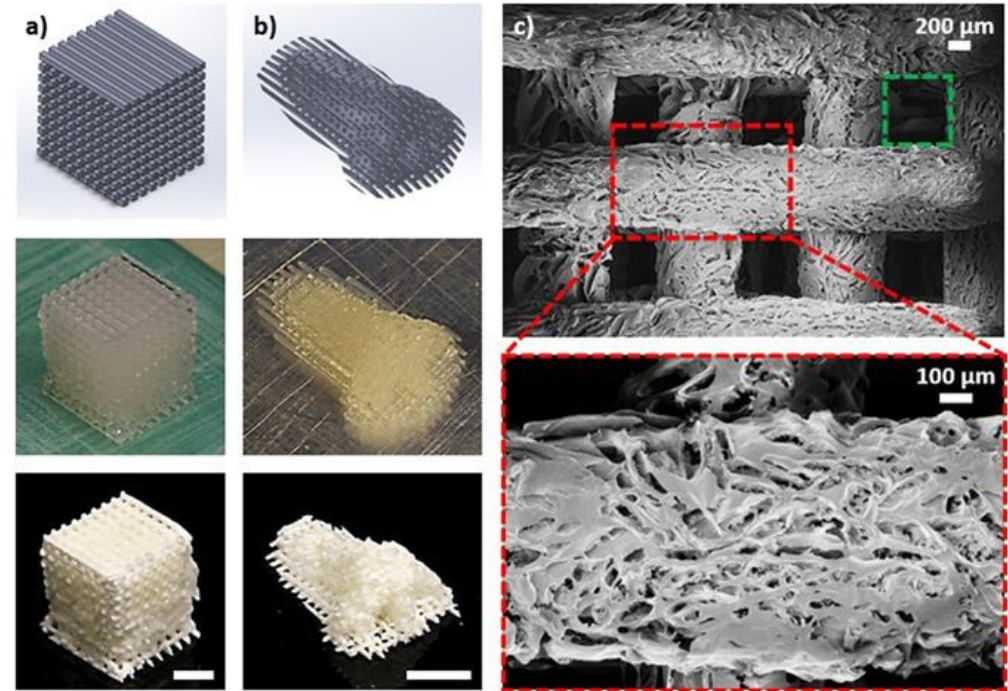
Figure 5. The DIW of aerogels in two distinct macrostructures, ( a ) a cube and ( b ) an ear. ( c ) The structural porosity, accounting for pores in the range of 600 µ m (green box) and the aerogel porosity, accounting for pores in the range of 20 to 800 µ m. Reprinted from [90] under open access license.